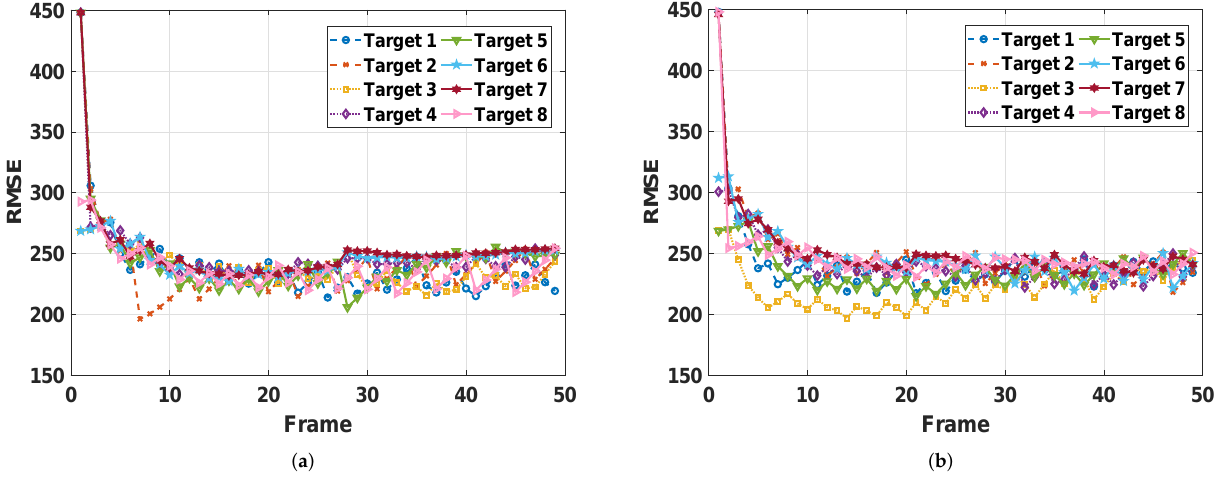
Figure 15. Tracking RMSEs of different targets. ( a ) γ = 0.5 ( b ) γ = 0.99.